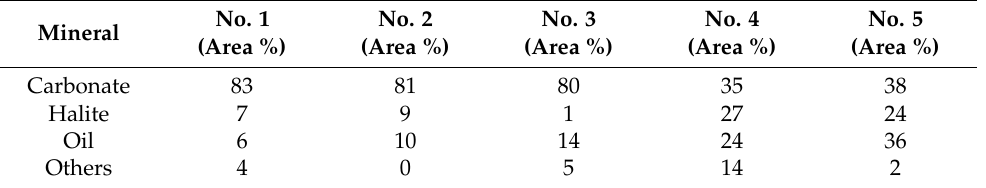
Figure 2. ( a – f ) SEM images of Chalk 1, Chalk 3, Chalk 5, Berea 1, Berea 5 and Silurian dolomite 2 respectively. ( g – l ) are the MLA images of Chalk 1, Chalk 3, Chalk 5, Berea 1, Berea 5 and Silurian dolomite 2 respectively. Table 4. Mineral list from the SEM-MLA analysis for chalk samples.